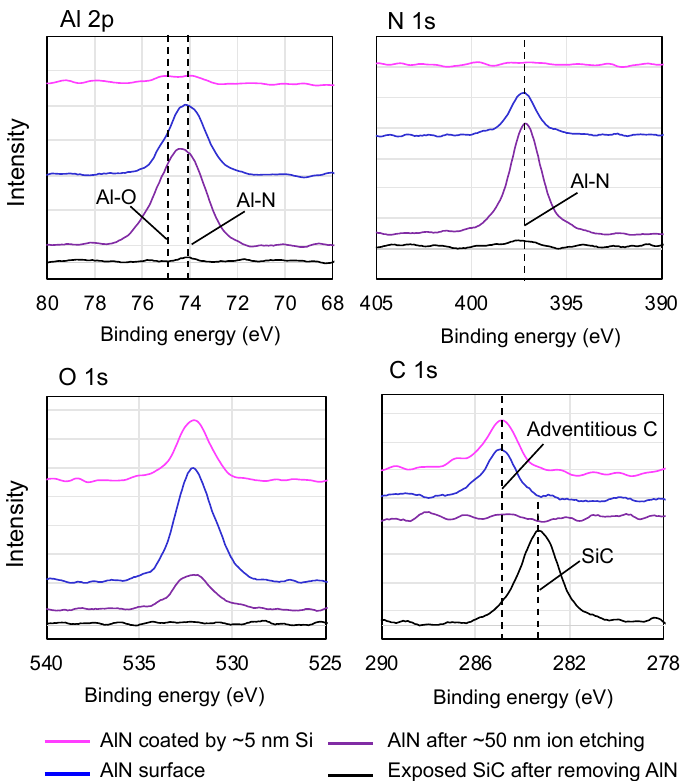
Figure 6. X-ray photoelectron spectroscopy (XPS) spectra of Al 2p, N 1s, O 1s, and C 1s taken from AlN film coated with ~5 nm Si layer (used for bonding in modified SAB), AlN film, the AlN film after ~50 nm etching by ion beam, and exposed SiC substrate after the complete etching of AlN, which are highlighted by magenta, blue, purple, and black.